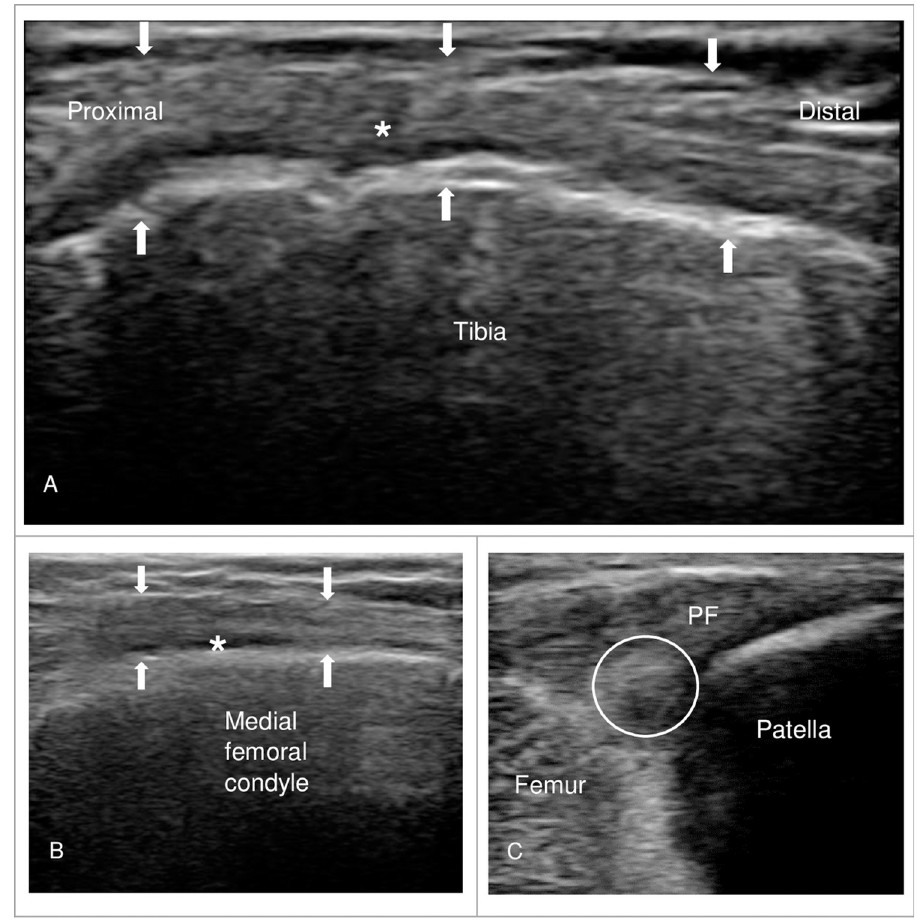
Fig 2. Sonographic examination images of a patient with KOA. (A) Coronal plane of the medial collateral ligament (MCL: white arrow) displaying mucoid degeneration (white star � ); (B) Hypoechoic appearance of the medial collateral ligament (white arrow) in transverse plan displaying effusion (white star � ); (C) Longitudinal view of the patellofemoral ligament (PFL) displaying hyperechoic change in the region of patella (white